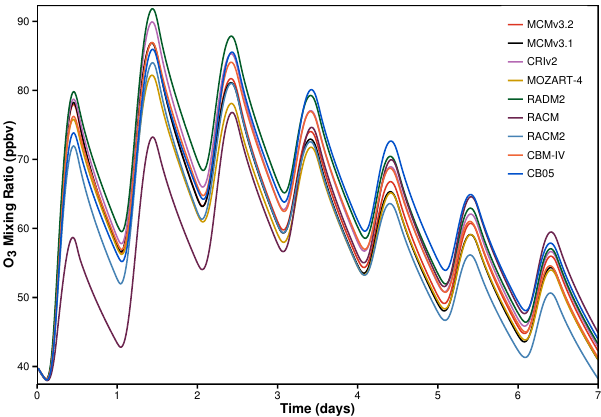
Figure 1. Time series of O 3 mixing ratios obtained using each mechanism.